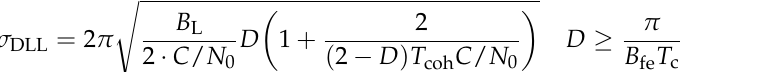
Figure 5. Simulation results of the motion error.